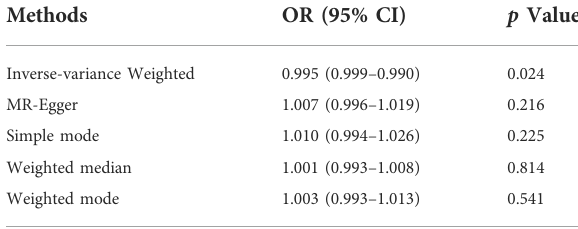
TABLE 2 Associations between genetically predicted vitamin D and risk of uterine fi